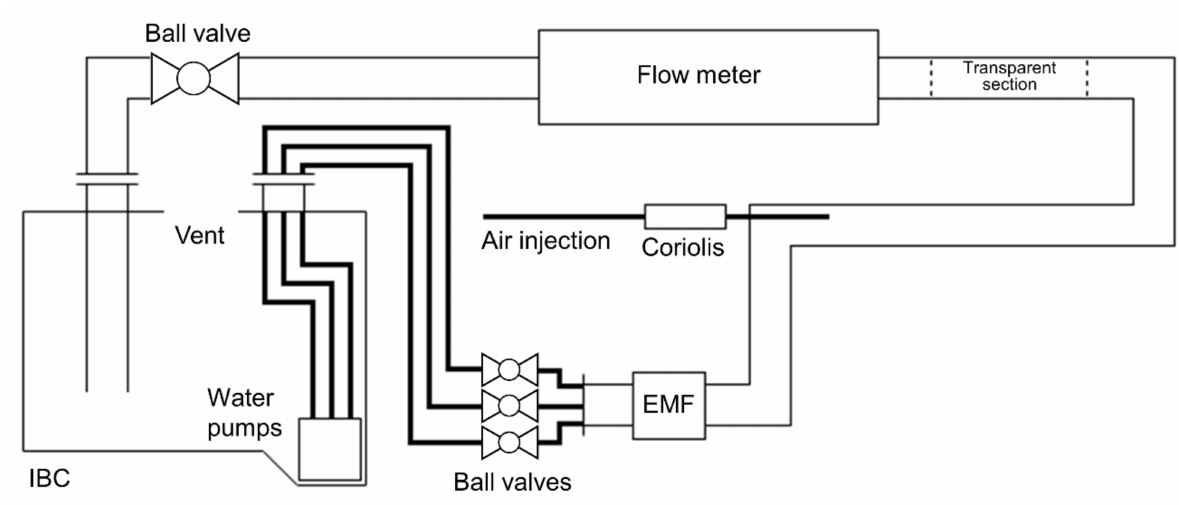
Figure 9. Schematic representation of the two-phase water-air flow loop used for the flow experiments presented in this work. Note that the air injection point, flow meter, and downstream ball valve of the flow loop were all placed at the same elevation above the IBC, making the piping horizontal over the entire length of the two-phase flow